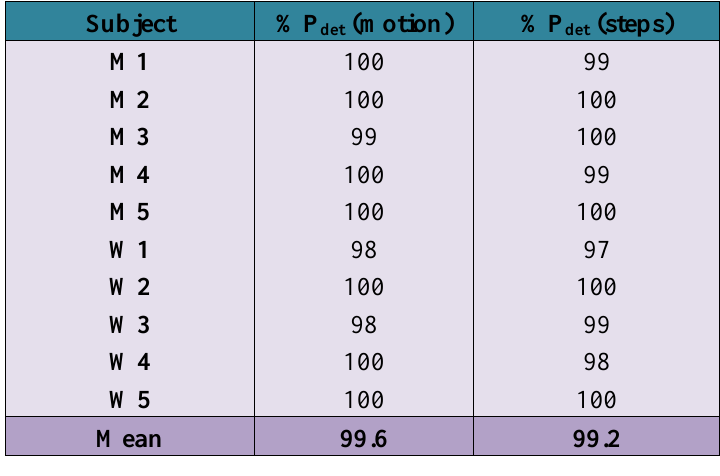
Table 4. Step detection algorithm performance for the ―controlled‖ data collection